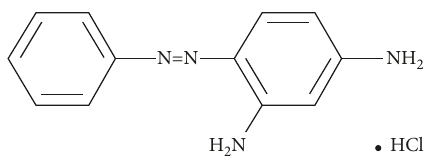
Figure 1: The structural formula of